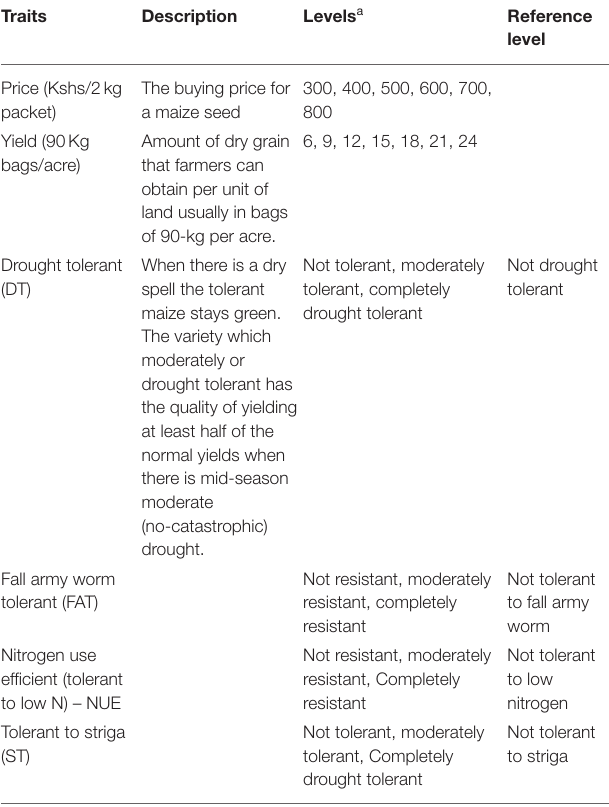
TABLE 1 | Summary of maize traits identified and used in the experiments.